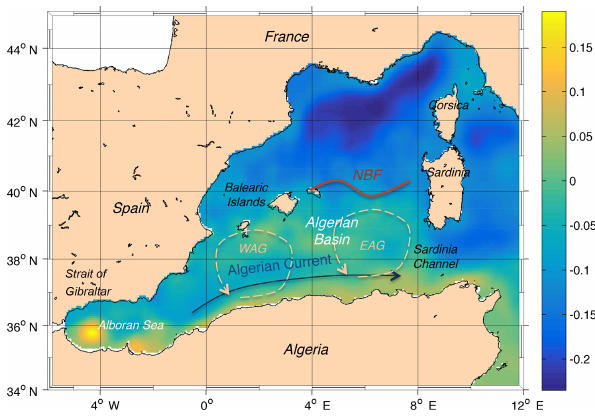
Figure 1. Mean dynamic topography (m) in the WMED (Rio et al.,